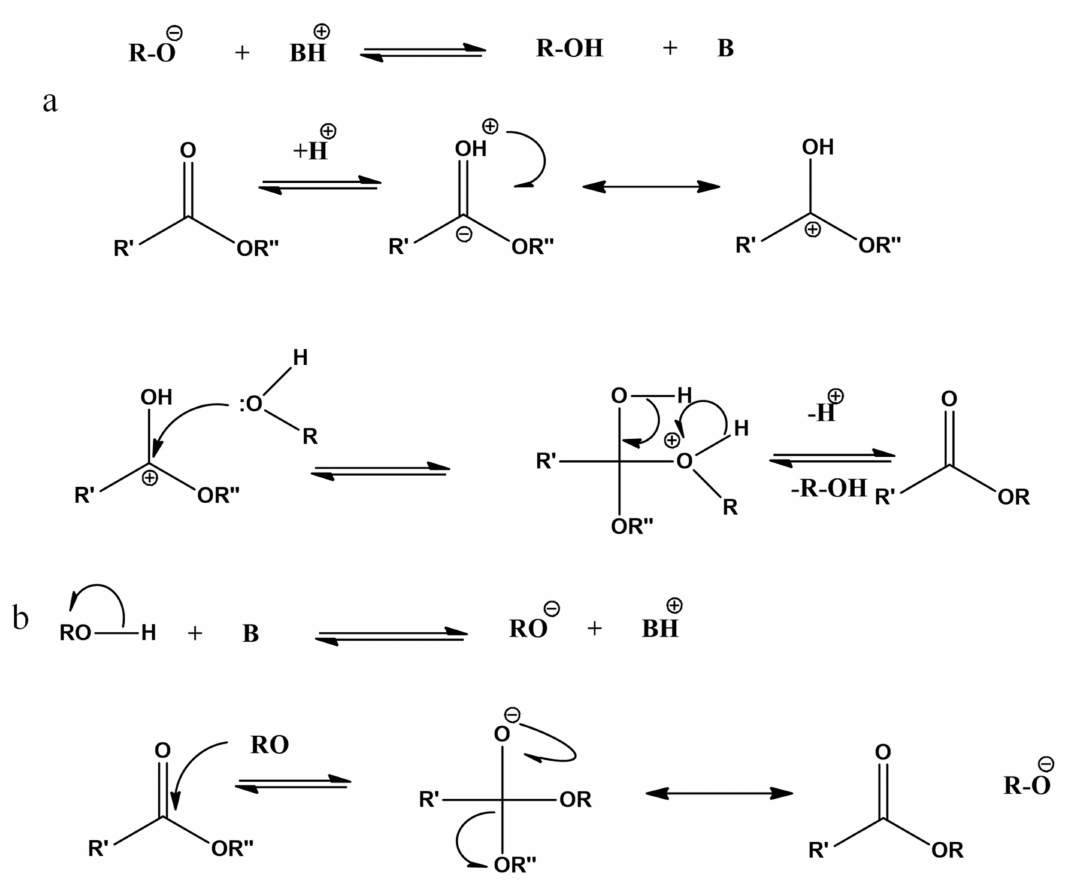
Figure 2. Chemical reaction ( a ) acid-catalyzed transesterification reaction pathways and ( b ) base-catalyzed transesterifica- tion